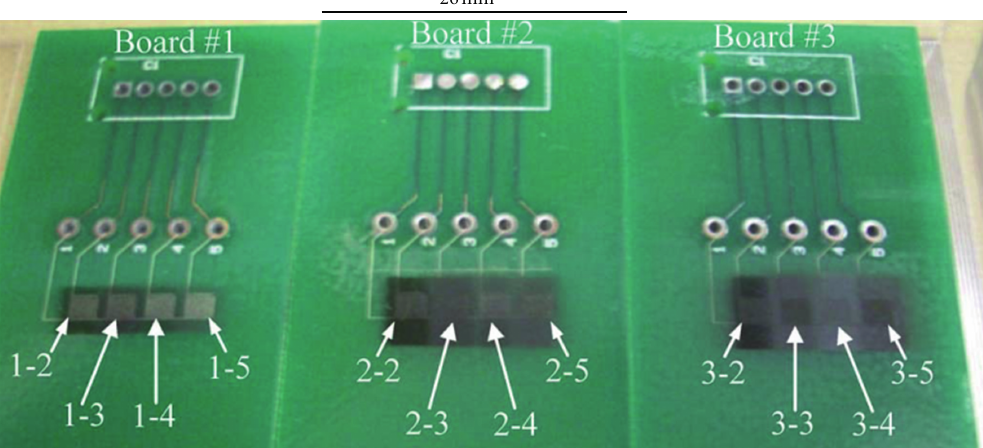
Figure 17: Optical micrograph of all-direct-written chemisensors for the detection of nerve gas, reprinted from Marinov et al. [93], Copyright 2007 IEEE.